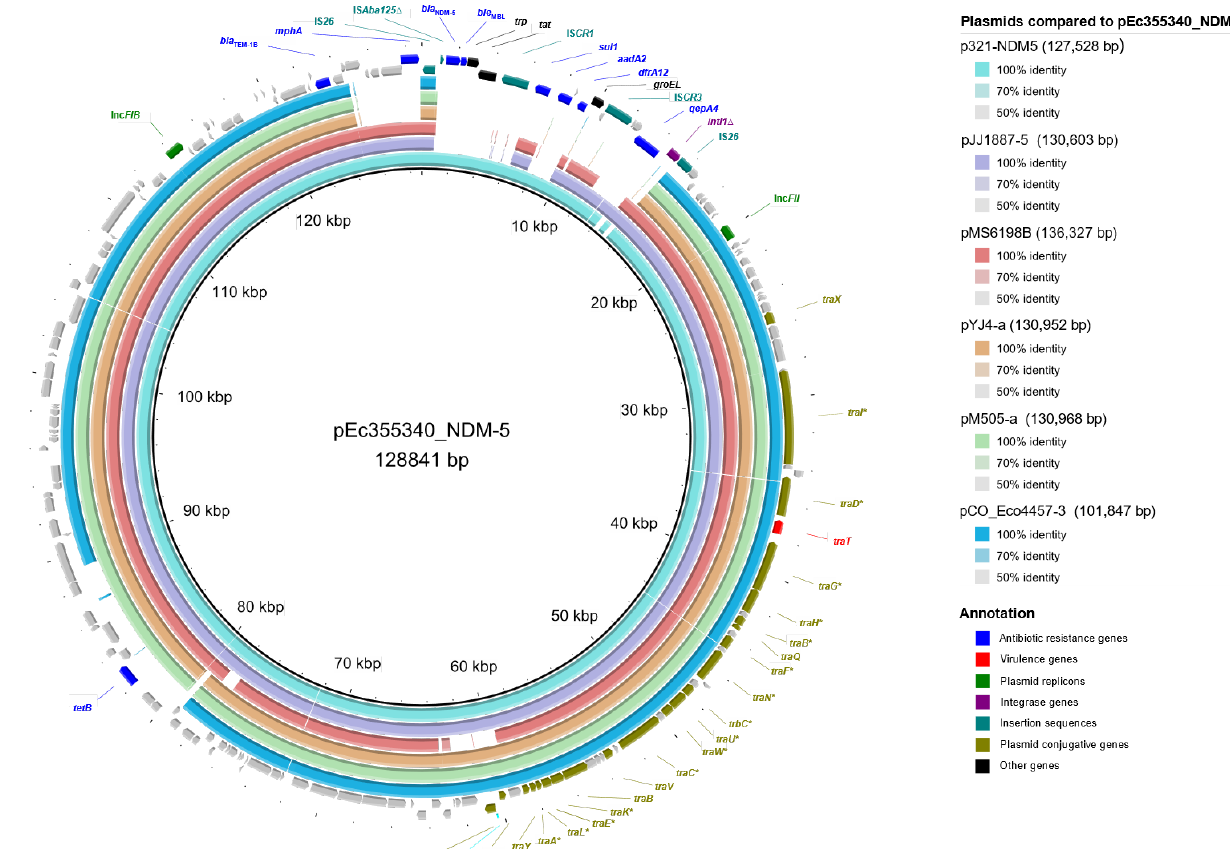
Figure 1. Plasmid sequence comparisons of pEc355340_NDM-5 with similar F-type plasmids identified by a discontinuous megaBLAST using BRIG software. The reference sequence was pEc355340_NDM-5, while rings, from inward to outward, represent the plasmids p321-NDM5 (CP076302), pJJ1887-5 (CP014320), pMS6198B (CP015836), pYJ4-a (AP023232), pM505-a (AP023221) and pCO_Eco4457-3 (CP049970). Gradient colour of the rings represents sequence similarity to the reference plasmid. The arrows in the two most outward rings represent all the coding sequences identified by RAST (https://rast.nmpdr.org/rast.cgi) in pEc355340_NDM-5. Annotation for several coding sequences is available in the figure and are colour-coded according with their function. The genes considered essential for conjugative transfer by Fernandez-Lopez et al. [20], are indicated with an asterisk (*). oriT was identified by oriTfinder (https://bioinfo-mml.sjtu.edu.cn/oriTfinder/) and is highlighted in light blue.